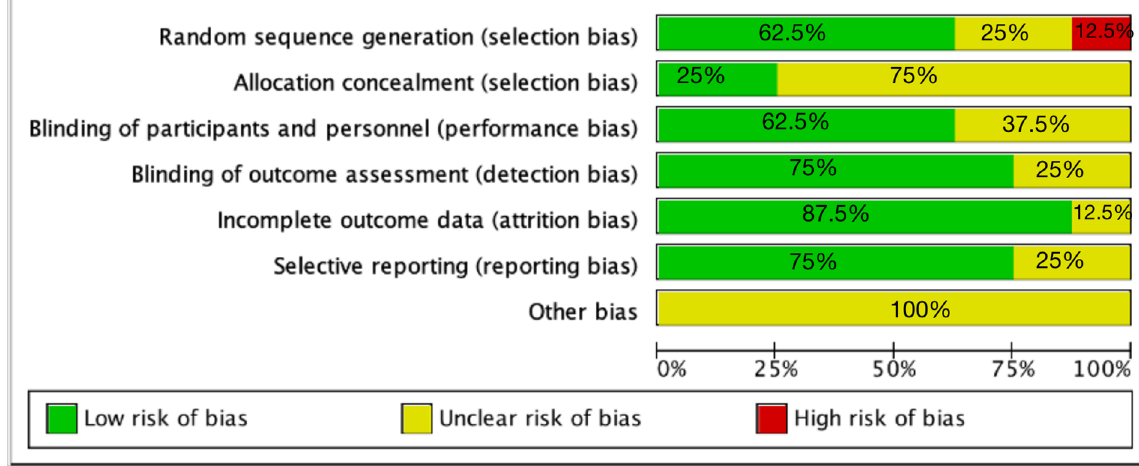
Figure 2. The risk of bias assessment.